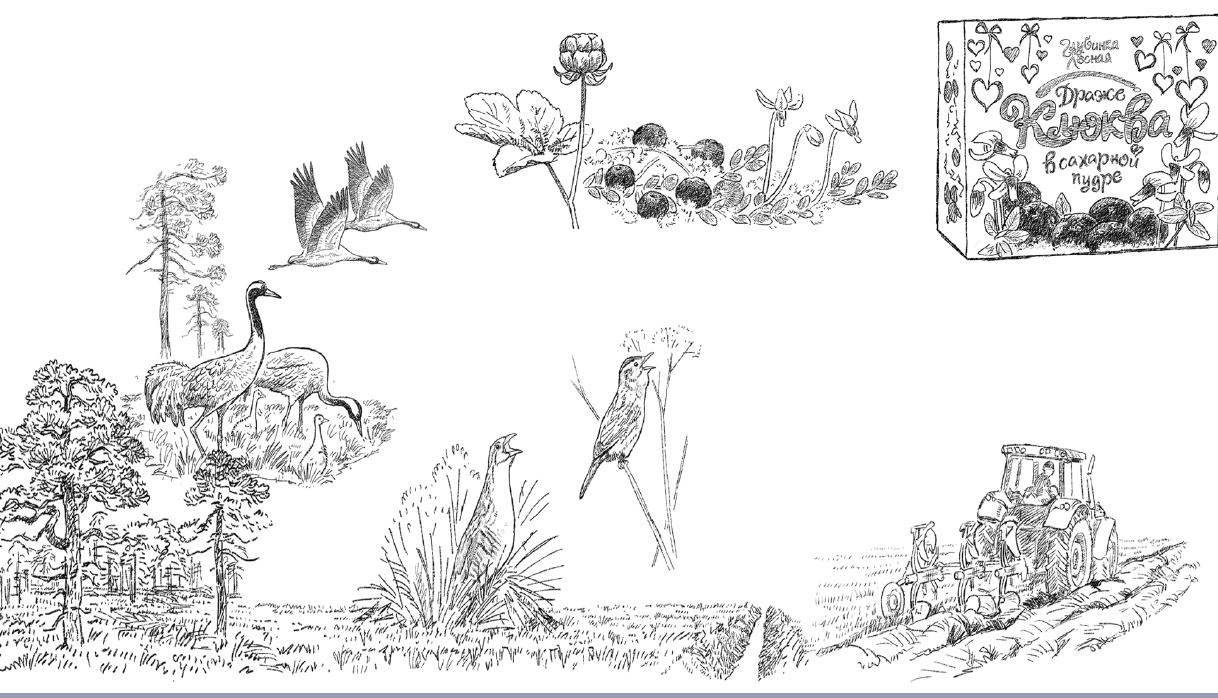
Fig. 1 . Illustration of the case studies “Bogs,” “Birds,” and “Berries.” Cases “Bogs” and “Birds” each focus on wetland restoration, to reduce greenhouse emissions from decaying peatlands, and promote species conservation. Draining of eutrophic fen mires, e.g., to increase agricultural land or wood production, destroys important habitats for globally endangered bird species like Corn Crake ( Crex crex ) and Aquatic Warbler ( Acrocephalus paludicola ; center). Landscapes with both large raised bogs (left) for safe roosting sites, and drained agricultural land (right) for food, are crucially important migration stopovers for Cranes ( Grus grus ). Case “Berries” focuses on value-added production based on cranberry ( Oxycoccus spp.) and cloudberry ( Rubus chaememorus ), both growing on raised bogs. Illustration by Martin